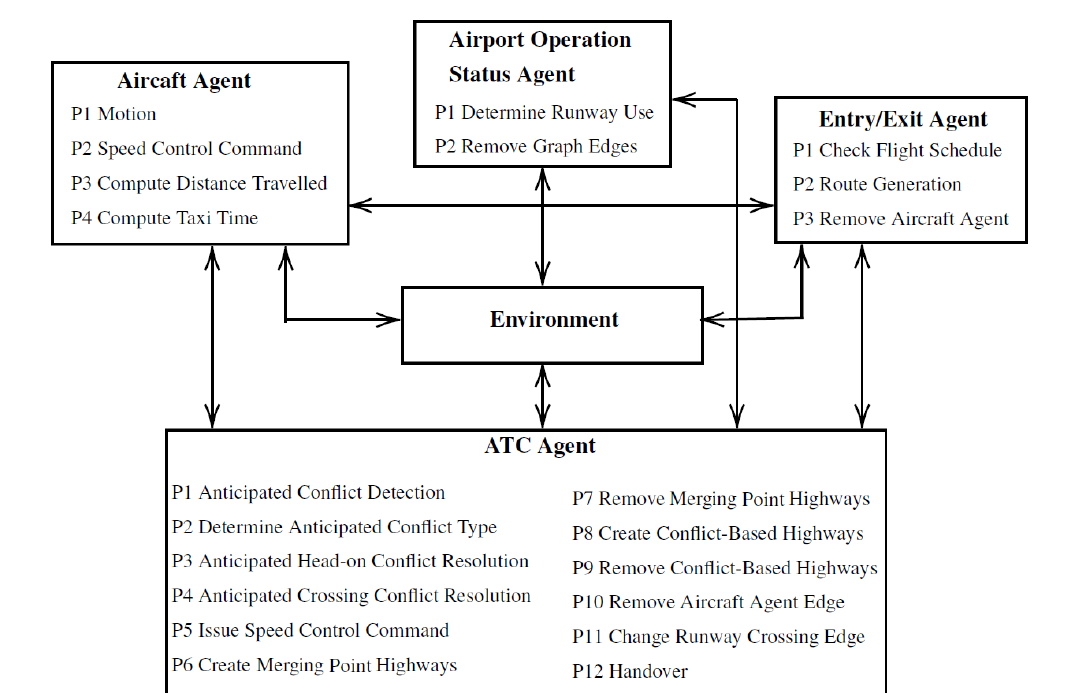
Figure 4. Properties of the four types of agents and their